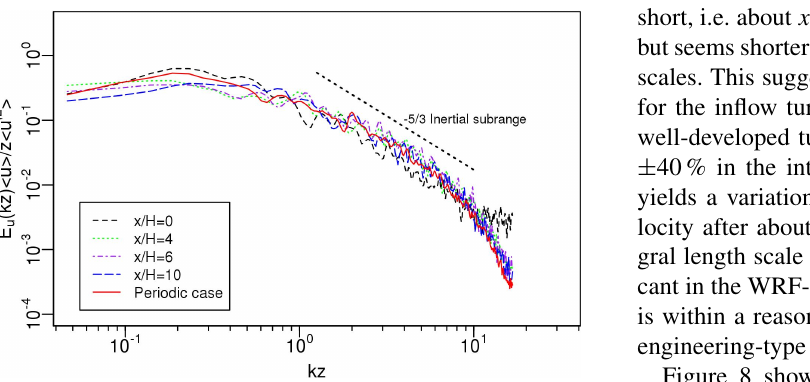
Figure 6. Spectra of streamwise velocity component for a series of downwind locations at the height of z/H = 0 . 5, k is the angular wavenumber, with (cid:104) u (cid:105) and (cid:104) u (cid:48) 2 (cid:105) the spatially averaged mean and streamwise normal turbulent stress, respectively.